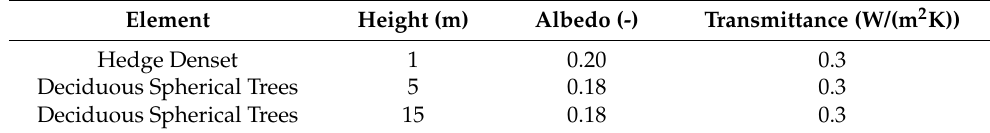
Table 2. Physical characteristics of the green